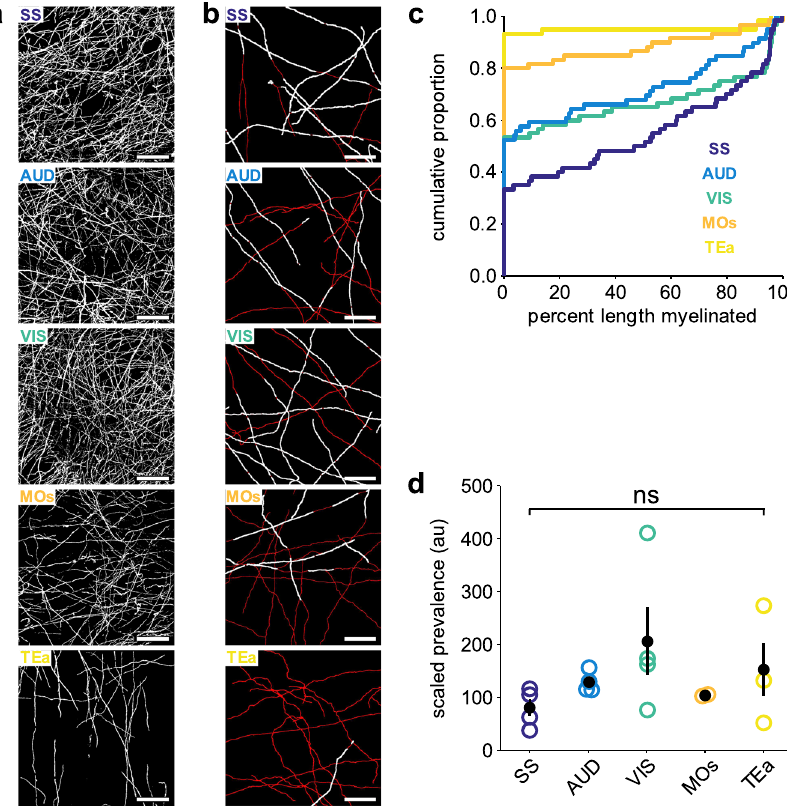
Fig. 3 PV axon myelination patterns are consistent across cortical regions. a Representative binarized images of MBP immunostaining from all cortical regions analyzed (SS somatosensory, AUD auditory, VIS visual, MOs secondary motor, TEa temporal association area). Scale bars, 50 μ m. b Example axon and myelin traces from each cortical region analyzed from a single PV-Cre; Ai9 fl atmount. Red, axons; white, myelin. Scale bars, 50 μ m. c Cumulative distribution plot of PLM from all axons traced in each region in a (SS, n = 60 axons from 4 mice; VIS, n = 60 axons from 4 mice; AUD, n = 59 axons from 4 mice; MOs, N = 30 axons from 2 mice; TEa, N = 37 axons from 3 mice). See Table 3 for PLM distribution statistics. d Scaled prevalence (MBP intensity/ proportion of axons myelinated) of PV axon myelination across all regions analyzed (same N s as in c ) (ns not signi fi cant, p = 0.24, Kruskal – Wallis ANOVA). Error bars represent the standard error of the mean. Source data and statistical tests are provided as a Source Data fi le.